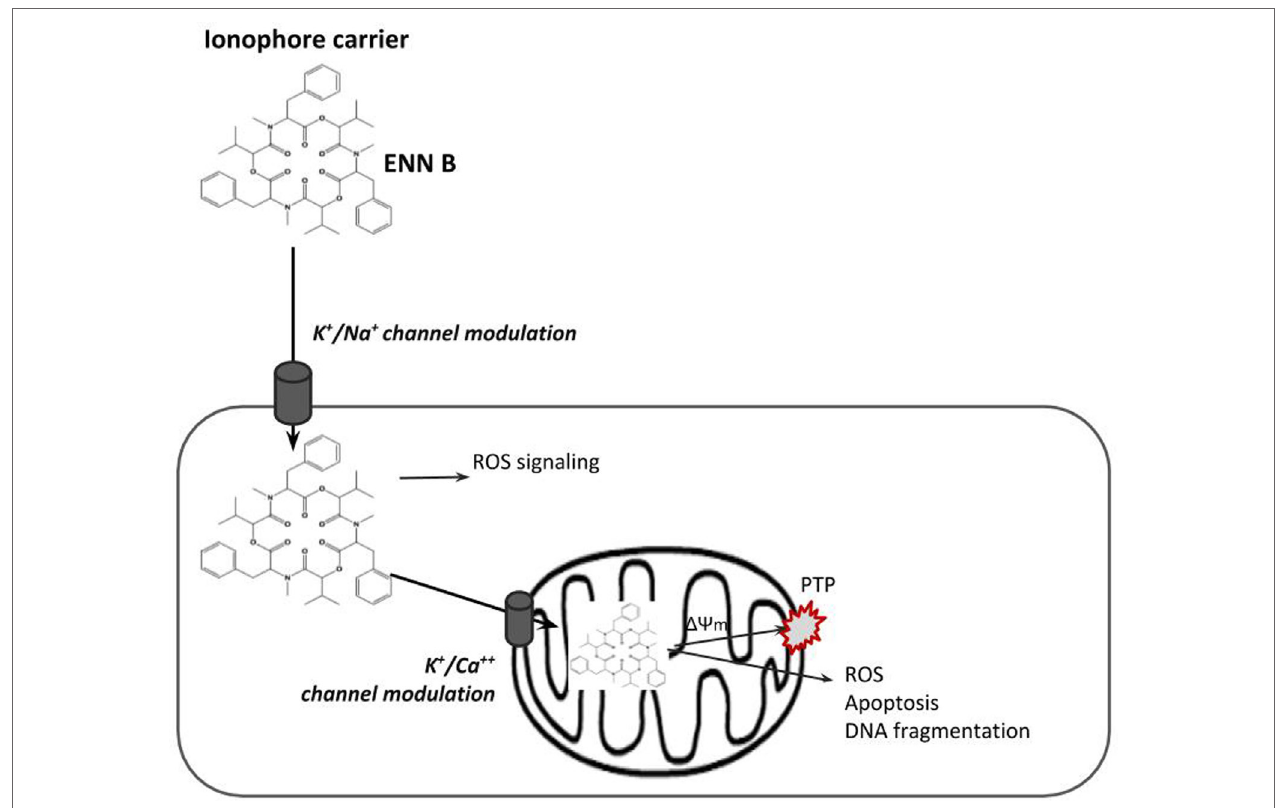
FiGURe 2 | Scheme of the ionophore enniatin (ENN) B carrying ions by diffusing through membrane